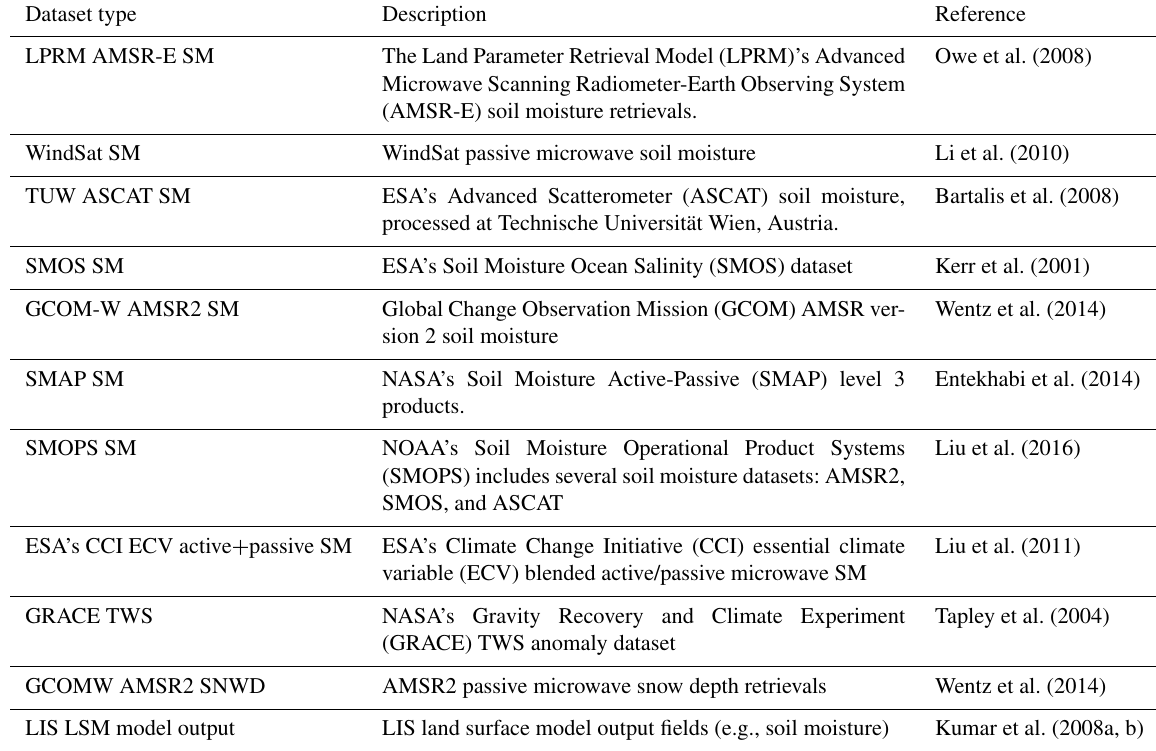
Table 2. Different DA remotely sensed observational or land surface model data types supported in LDT and LIS. Dataset